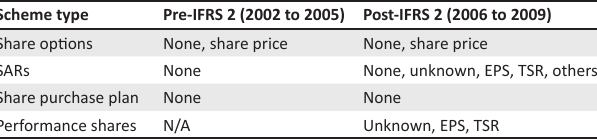
TABLE 2: Performance vesting conditions of the different schemes. Scheme type